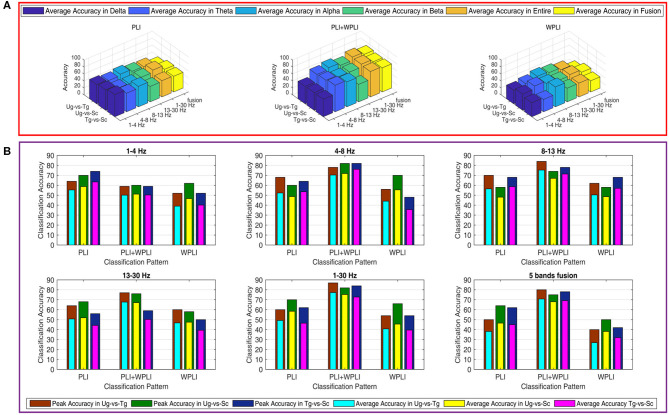
Classification accuracies in fusion time windows. (A) Comparison in a special method (PLI, WPLI, or PLI+WPLI). The bar denotes the average accuracy on a special combination condition (frequency band and pair-intentions). (B) Comparison among the three methods (PLI, WPLI, and PLI+WPLI). The external layer bar is the maximum classification accuracy and the inner layer bar represents the average classification accuracy.